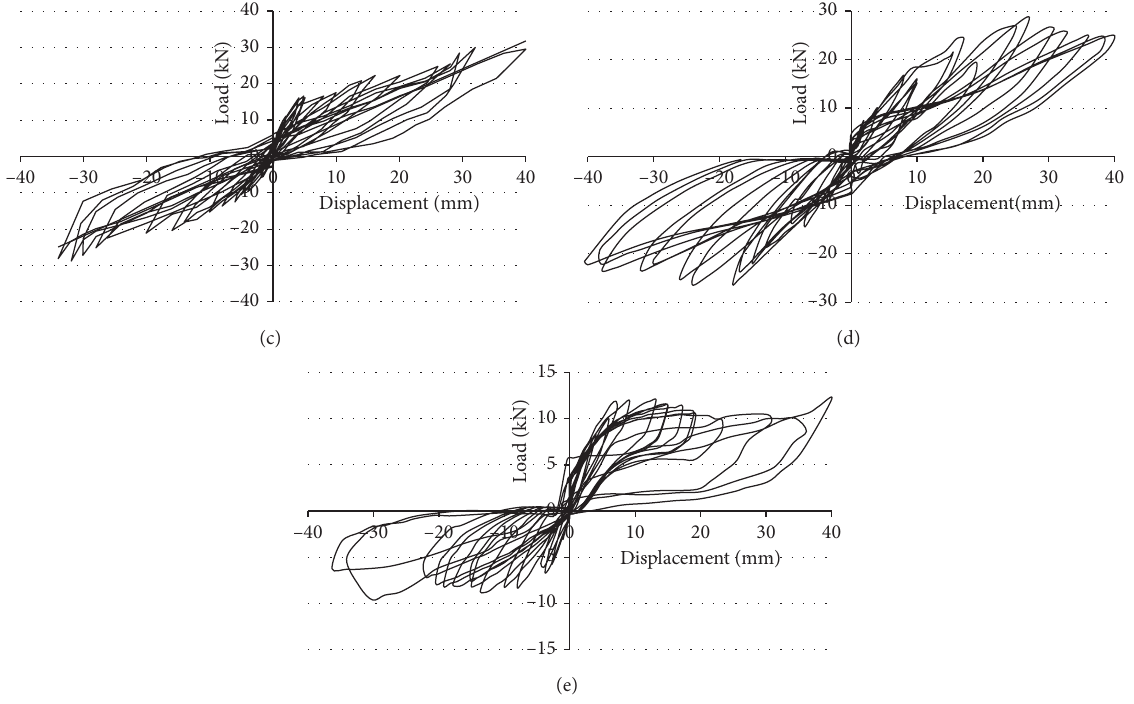
Figure 16: (a) Load-displacement hysteresis loop of monolithic connection, (b) load-displacement hysteresis loop of PCBJ connection, (c) load-displacement hysteresis loop of PC I connection, (d) load-displacement hysteresis loop of PC II connection, and (e) load-dis- placement hysteresis loop of GS